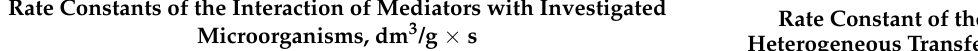
Rate Constant of the Heterogeneous Transfer to the Electrode, cm · s − 1 [27] Ps.